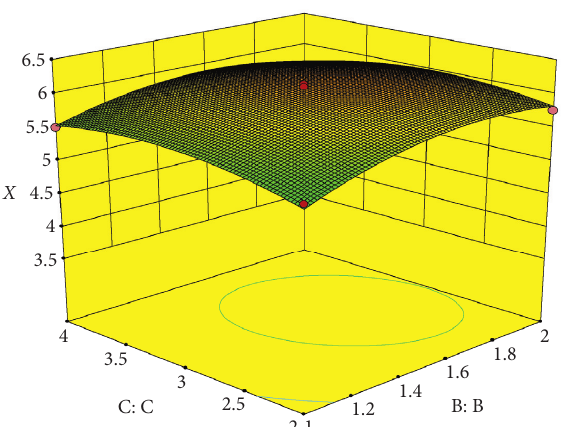
Figure 11: The interaction term BC.